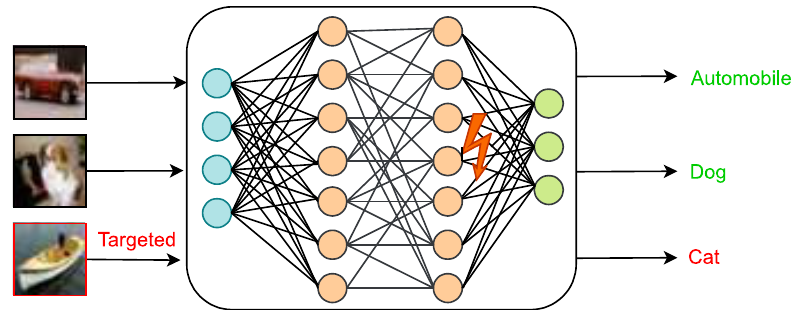
Figure 11. The targeted attack